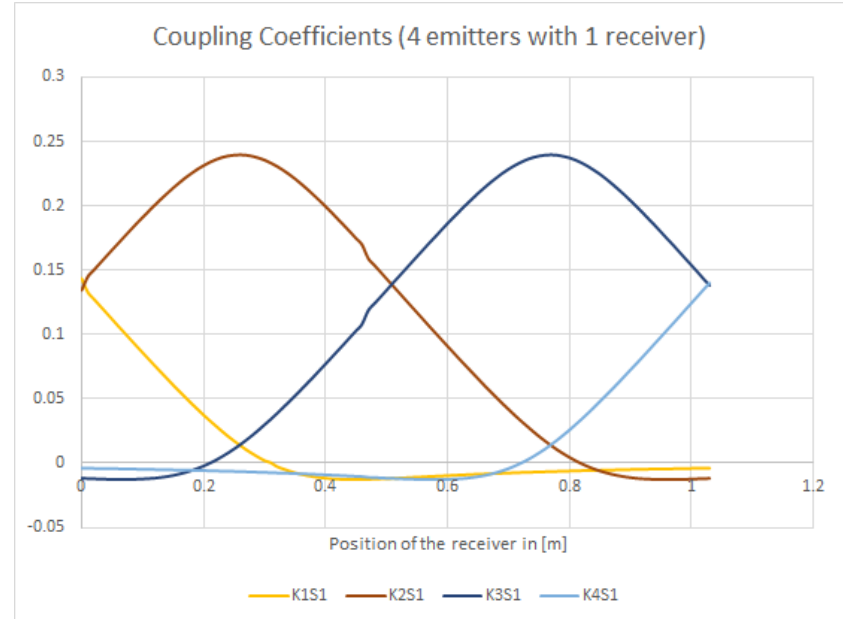
Figure A6. Coupling values get updated as a function of the receiver’s position.